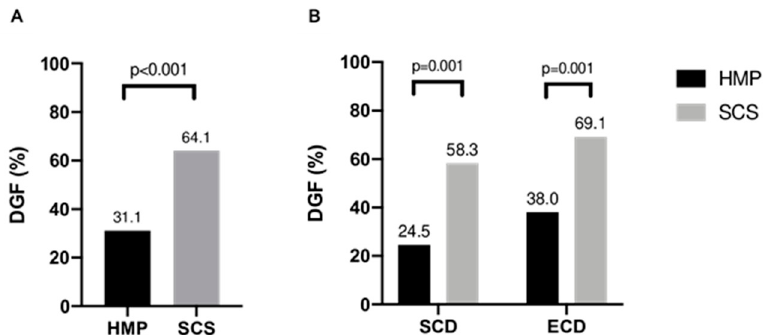
Figure 2. ( A ) Delayed graft function rate of hypothermically perfused deceased donor kidneys compared to kidneys statically stored on ice; ( B ) delayed graft function rate of kidneys after hypothermic machine perfusion compared to organs stored on ice stratified for standard and extended criteria